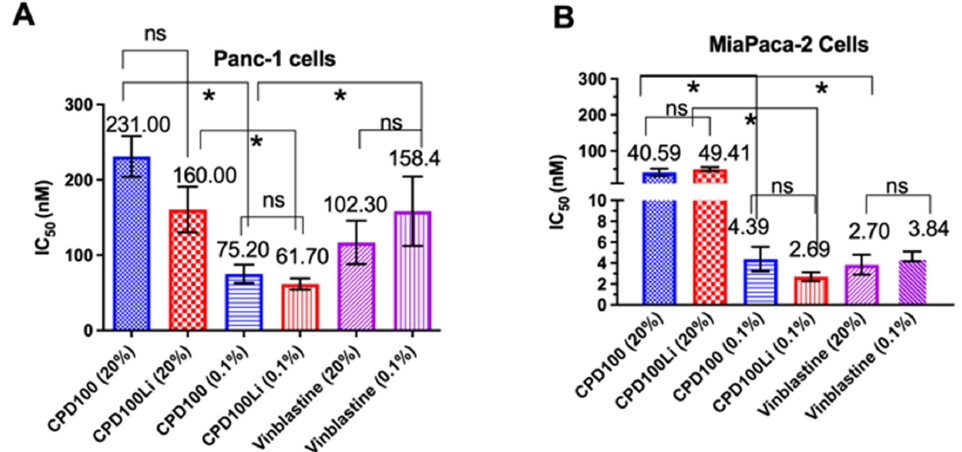
Figure 1. In vitro antiproliferative efficacy of CPD100 and CPD100Li in the PDAC cells lines. In vitro efficacy of CPD100, CPD100Li, and vinblastine (parent compound) under 20% and 0.1% oxygen in the Panc-1 ( A ) and MiaPaCa-2 ( B ) human pancreatic cancer cell lines measured using the CellTiter Blue ® assay. Data are represented as the mean ± SD of four replicates. ns ( p > 0.05), and * ( p ≤ 0.05), represent the statistical significance compared to the control group by one-way ANOVA.